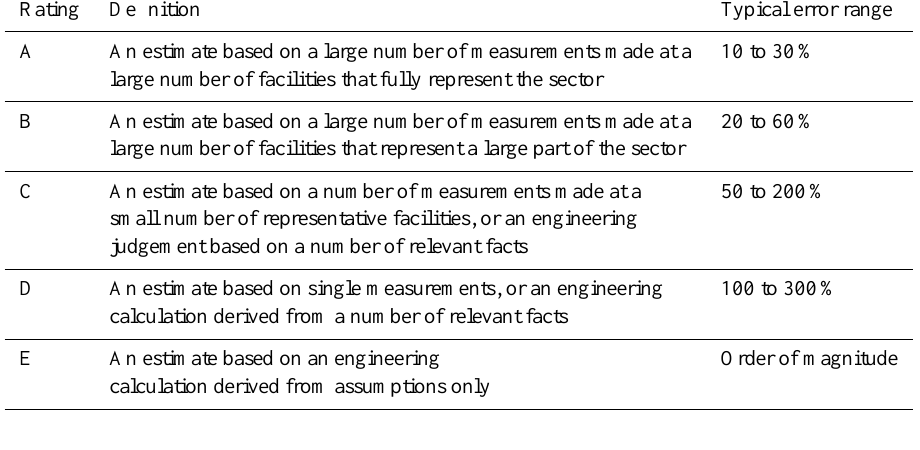
Table 4. Uncertainty rating definitions used for air pollutants in the Emission Inventory Guidebook (source: EEA, 2013).